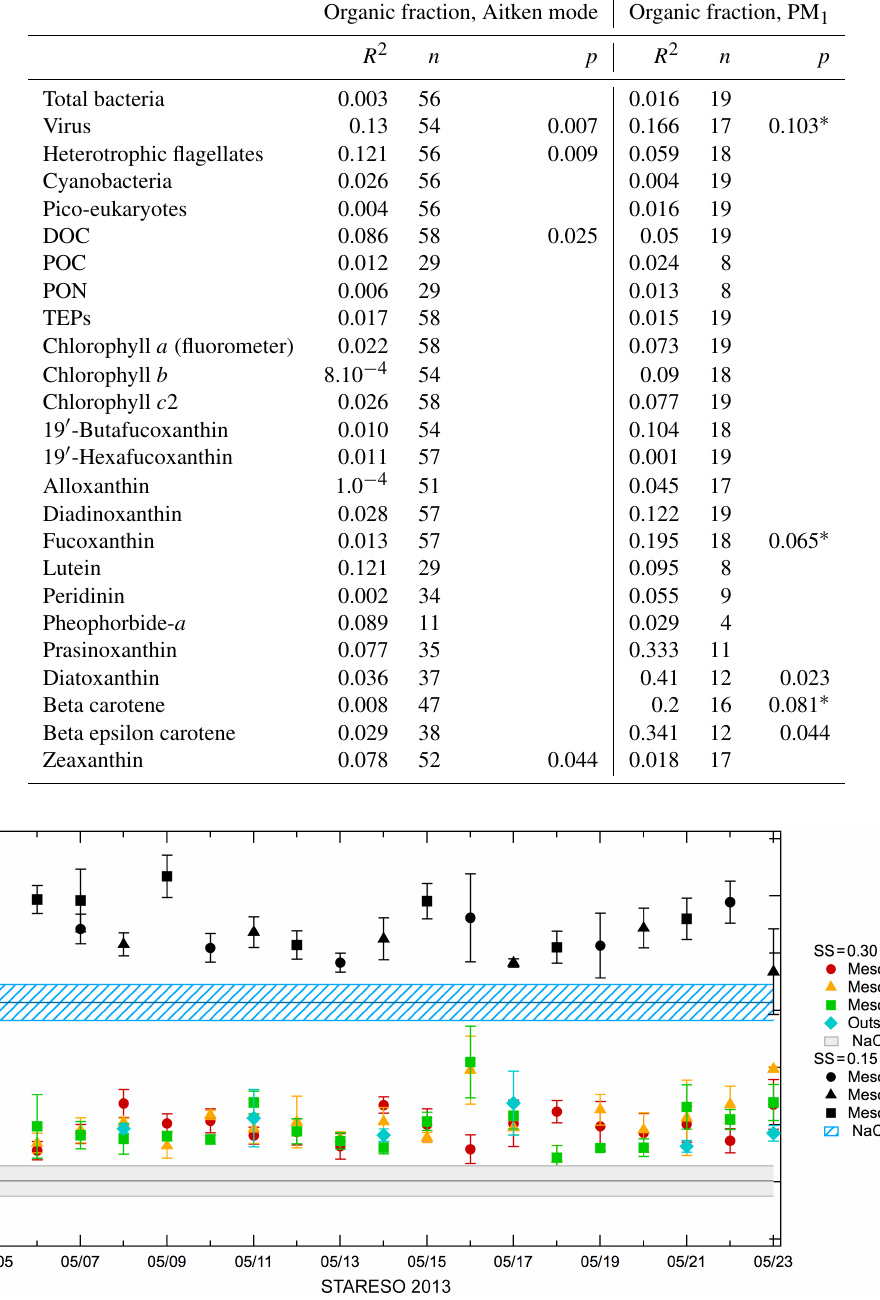
Table 4. R 2 values, number of sample points ( n ) and p values at the 95% confidence level ( p ) of correlations between different biogeochem- ical parameters and the particle organic fractions calculated from the CCNc at SS = 0.30% (representing 60nm particles) or from a quartz filter collection (representing < 1000nm particles) from averaged data of all mesocosms. The p values are given for significant correlations at the 95% confidence level and noted with an asterisk (*) when significant at the 90% confidence level. The p significance takes into account the number of observations.